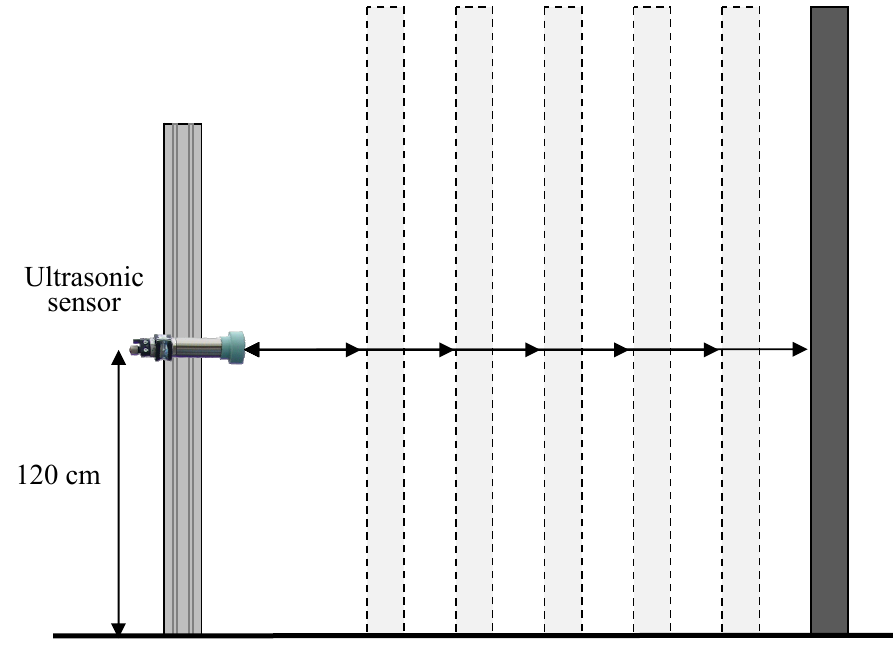
Figure 3. Experiment layout for the laboratory distance measurement